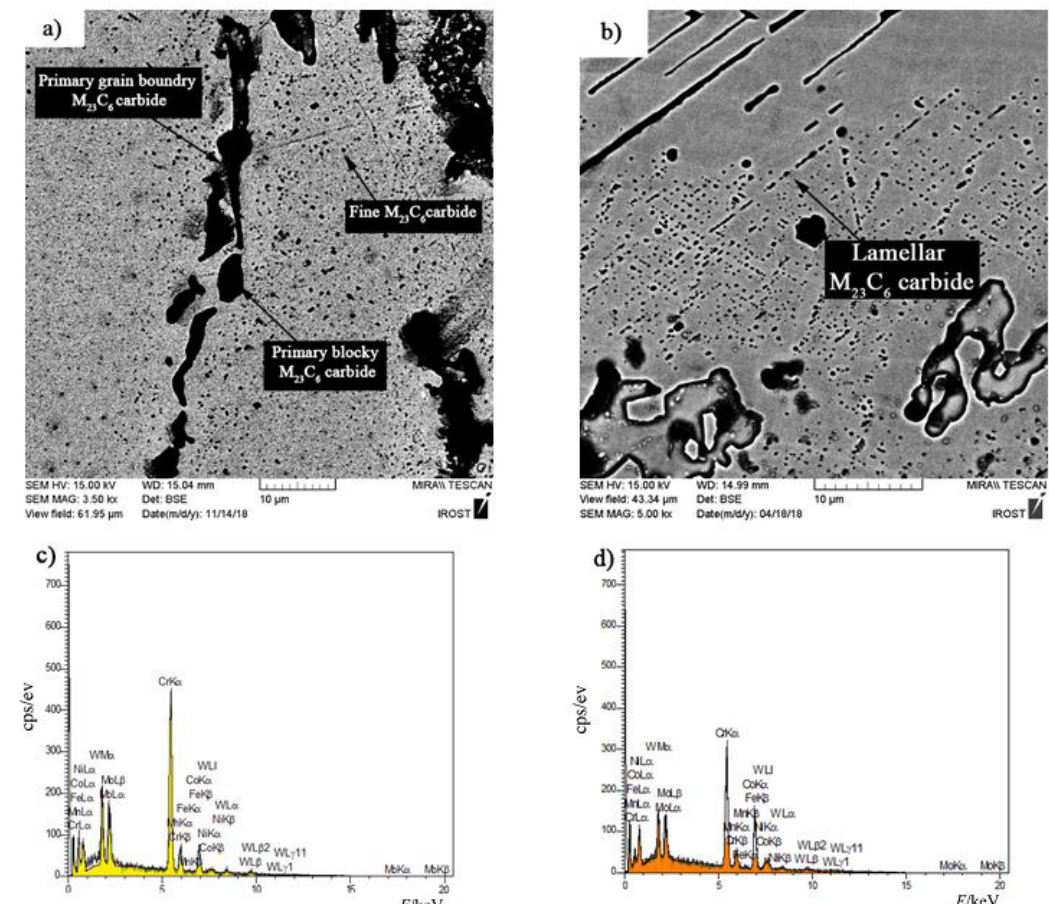
Figure 11. Optical microscopy of microstructural evolution of X-45 at a constant time of 10 min and different tempera-